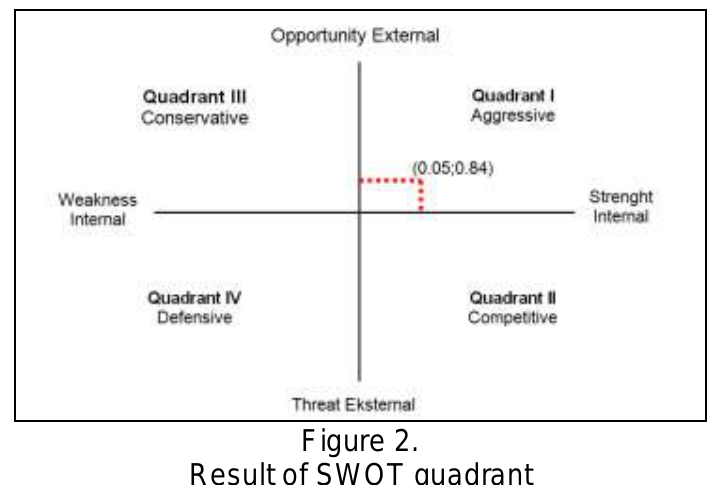
Figure 2. Result of SWOT